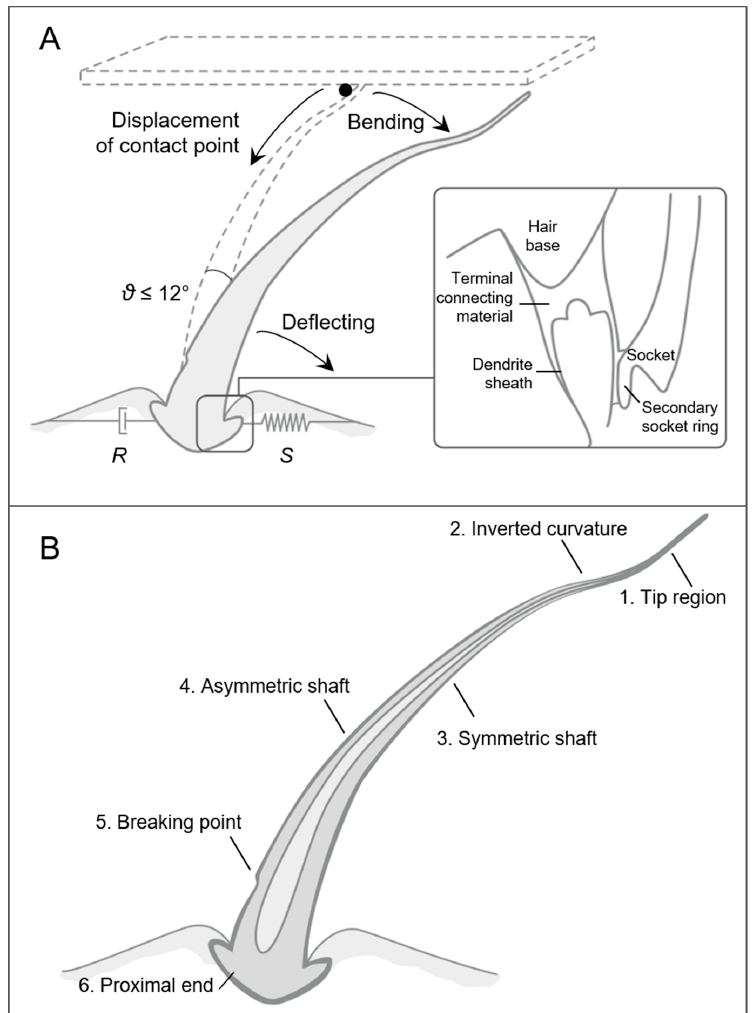
Figure 4. Biomechanical principles of spider tactile hairs in tactile sensing. ( A ) Bending in addition to deflection protects the hair against breaking. The maximum deflection angle of the hair θ is 12°, with a damping element R and a spring element S . (Inset) The hair base is finely tuned, with the presence of a “terminal connecting material” and a “second joint”, described in the text (reprinted by permission from Springer, [81]). ( B ) Regional heterogeneity along the hair attributes different functions and optimization of each part (reprinted by permission from Springer, [56]). The regions depicted have the following characteristics: (1) plastic region, abrupt decrease of lumen diameter, strong curvature in different directions; (2) approximately one third of hair length, not found in all hairs; (3) rotational symmetry; (4) strong deflections, wall of the hair thicker towards the tarsus; (5) decrease of outer diameter towards the base; (6) morphologically and functionally most complex structure of the hair.